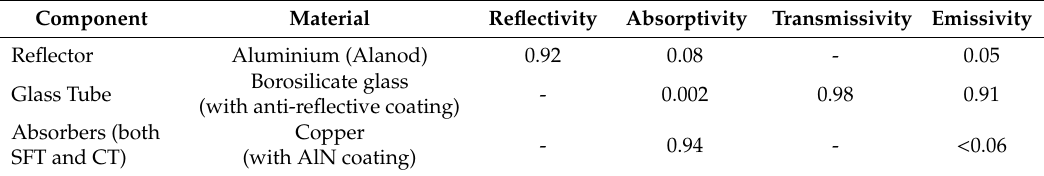
Table 3. Properties of CPC components for ray tracing